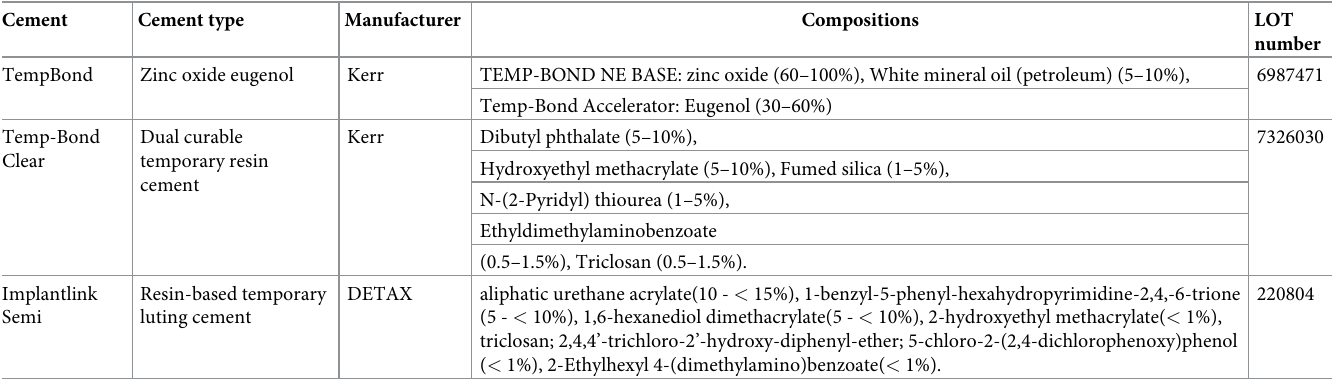
Table 1. Type, manufacturer, composition (%) and LOT number of the